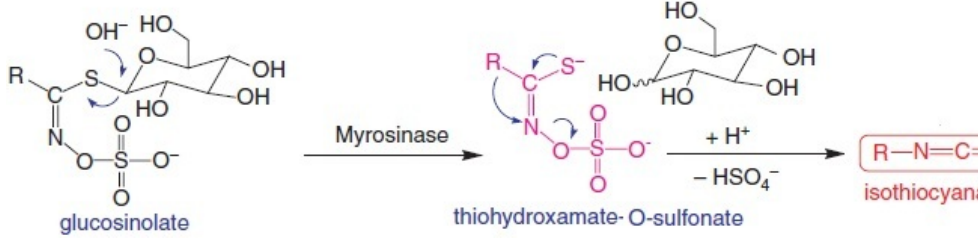
Figure 2. Enzyme myrosinase present in plant tissues or intestinal flora catalyses the breakdown of glucosinolates such as glucoraphanin to isothiocyanate sulforaphane. Multiple action mechanisms inherent to the anticancer properties of SFN have been reported